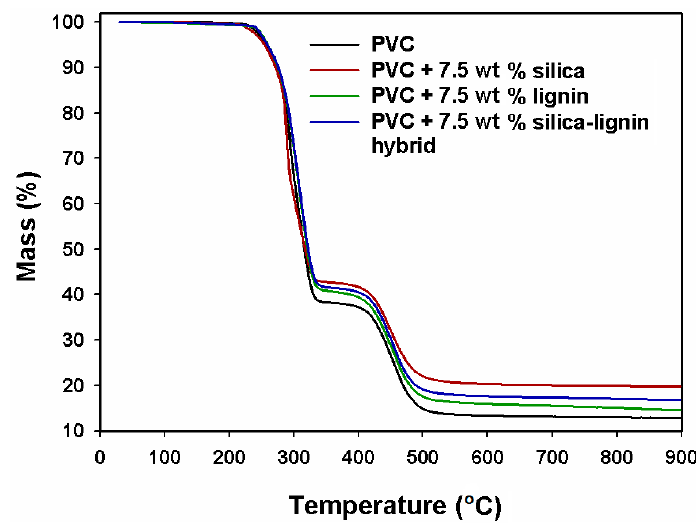
Figure 5. TG curves of PVC and PVC-based composites with 7.5 wt % filler content.